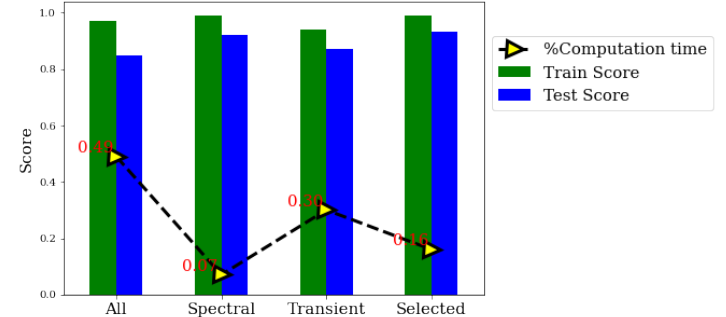
Figure 10. Cost assessment for the proposed